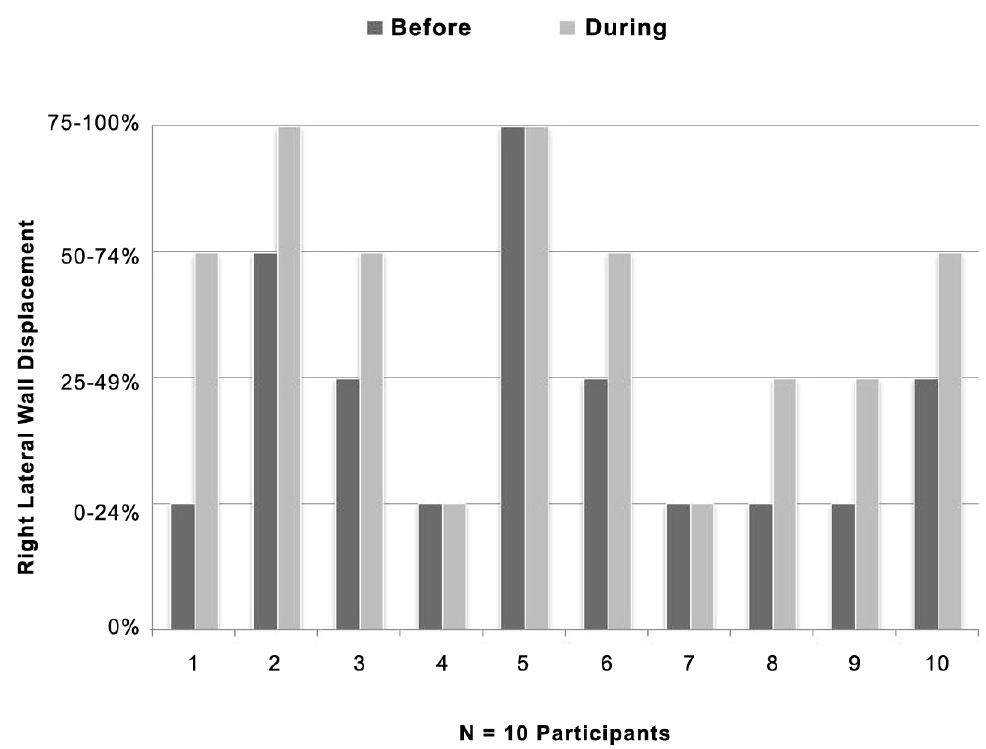
FIGURE 2- Maximum right lateral pharyngeal wall displacement before and after diagnostic therapy for all 10